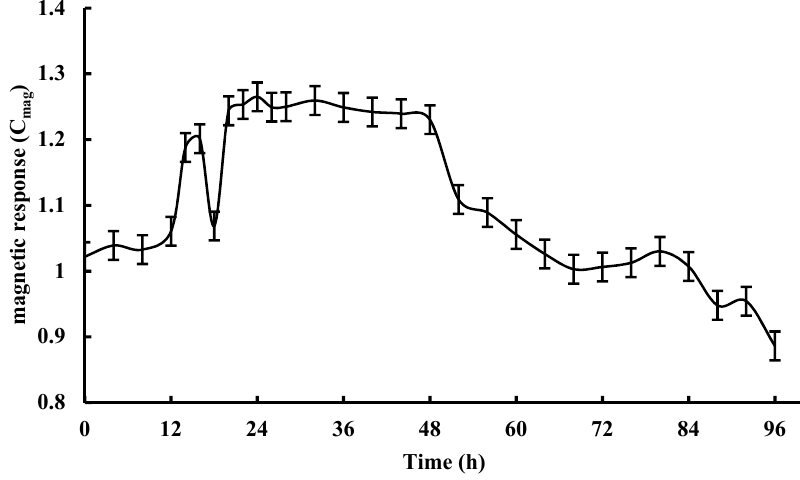
Figure 2. The magnetic response (C mag ) of magnetotactic bacteria AMB-1.